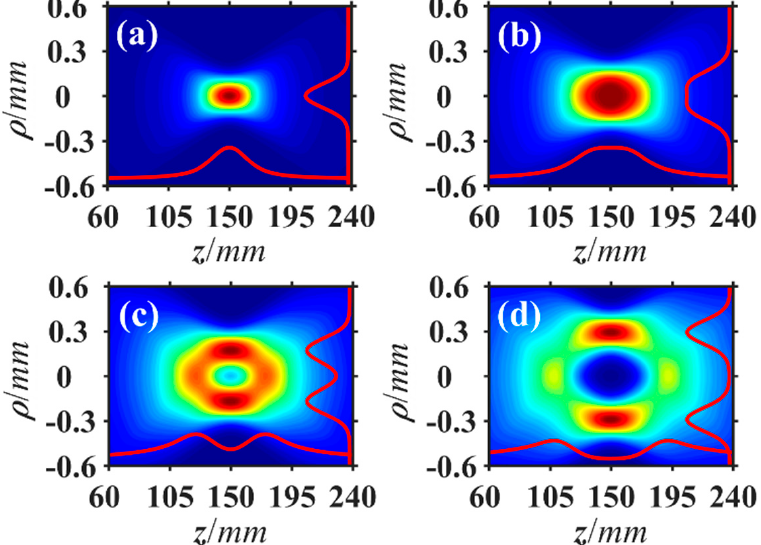
Figure 3. Normalized intensity distribution of an apertured BGCSM beam focused by a thin lens in the ρ – z plane for different values of β with a = 1.5 mm and δ 0 = 0.2 mm. ( a ) β = 0; ( b ) β = 1.5; ( c ) β = 2.5; and ( d ) β = 4.